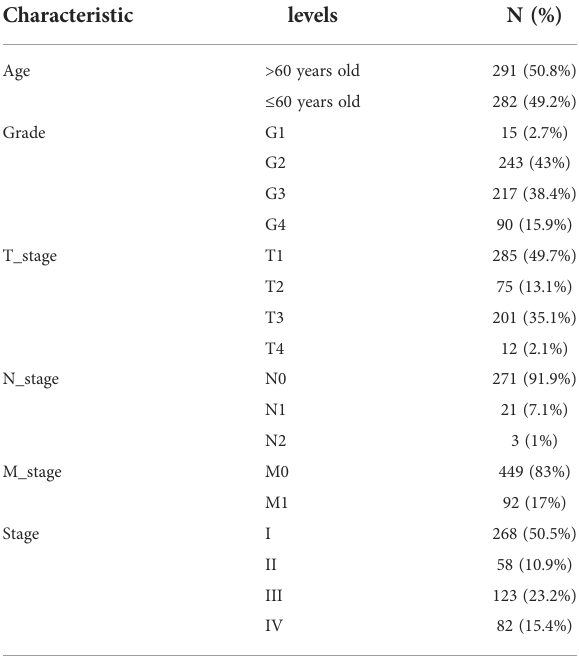
TABLE 1 Baseline Data Sheet for the Comprehensive Cohort of TCGA-KIRC and GSE29609.